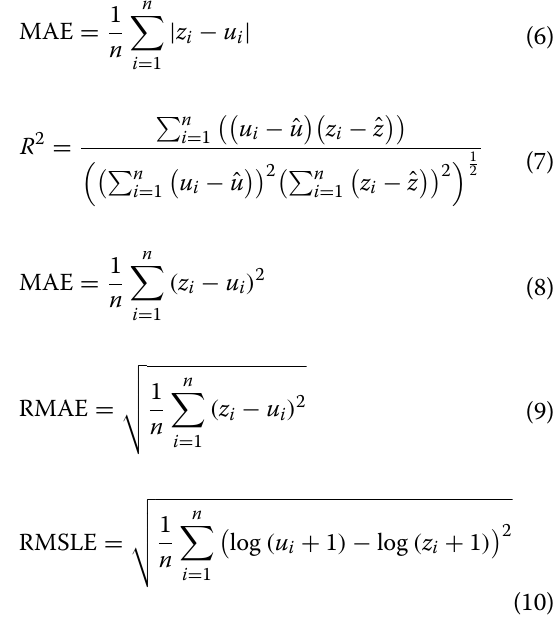
Table 1 Statistical description of the PVT data PVT